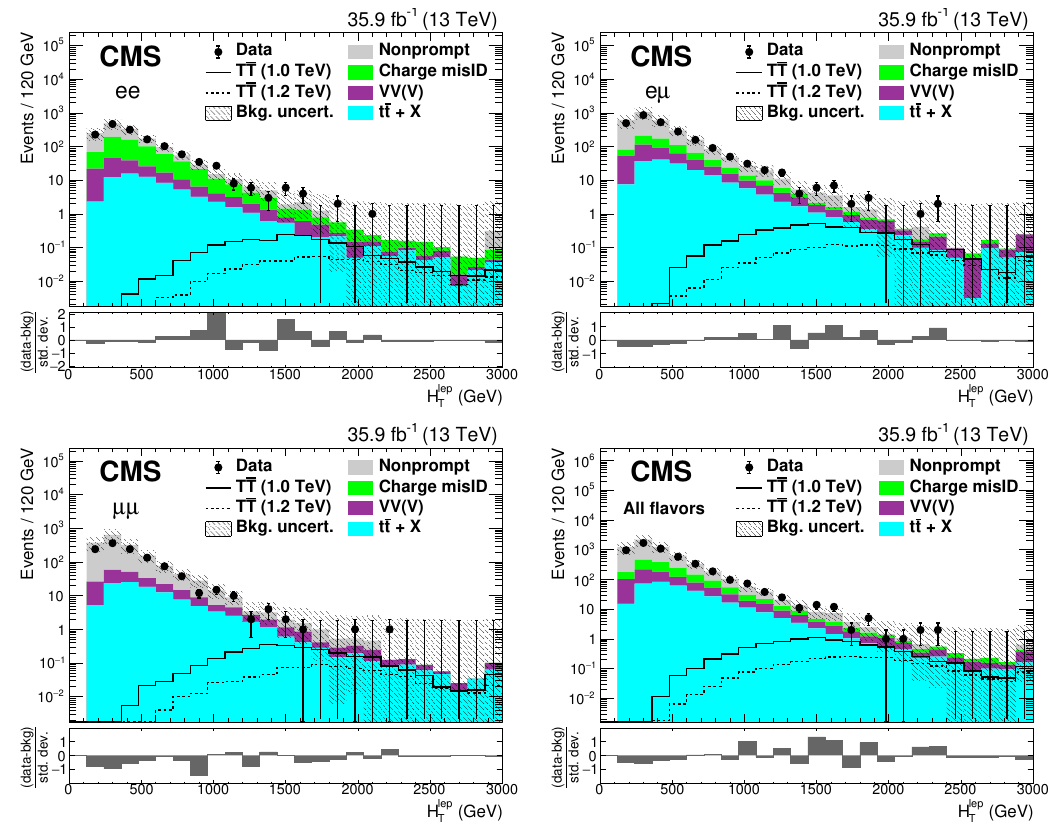
Figure 3 . The H lep distributions before the (cid:12)t to data in events with at least two jets after the T SS dilepton selection and Z-boson/quarkonia vetoes, for the ee, e (cid:22) , and (cid:22)(cid:22) categories, and for the combination of all categories. The black points are the data and the (cid:12)lled histograms show the background distributions, with simulated backgrounds grouped into categories as described in section 3. The expected signal is shown by solid and dotted lines for T quark masses of 1.0 and 1.2 TeV. The (cid:12)nal bin includes over(cid:13)ow events. Uncertainties, indicated by the hatched area, include both statistical and systematic components. The lower panel shows the di(cid:11)erence between data and background divided by the total uncertainty. Accepted events are required to have H lep > 1200 T